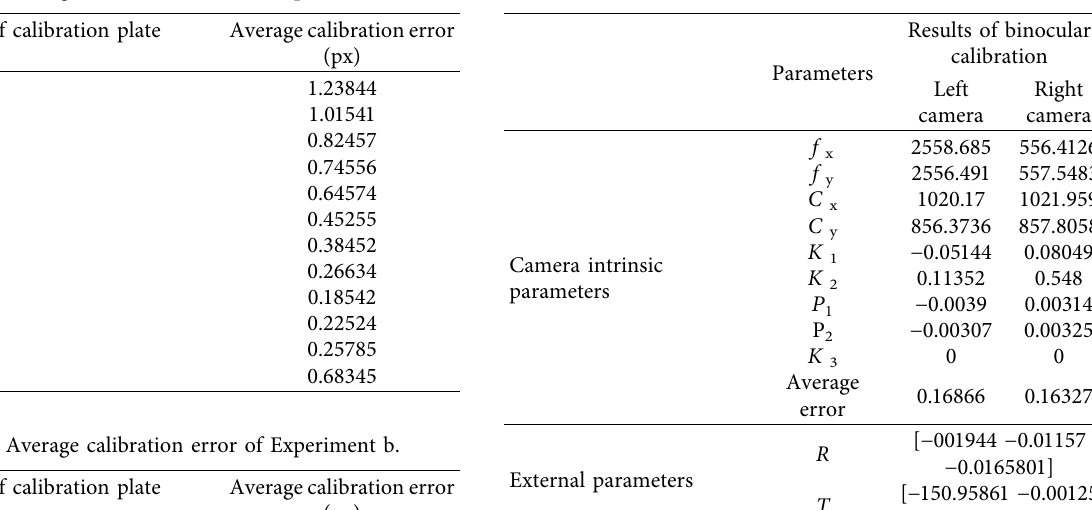
Table 4: Results of binocular